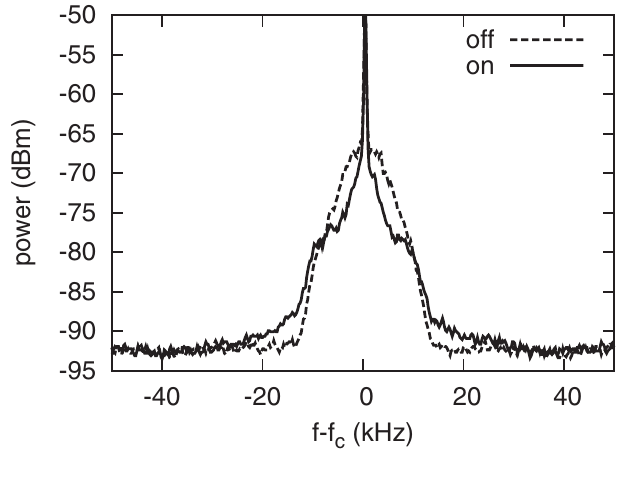
FIG. 5. Signal suppression near 5.2 GHz.